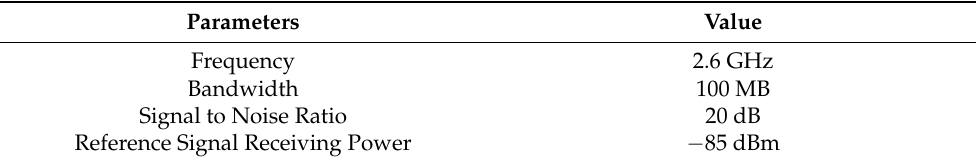
Table 1. Parameters of 5G networks.